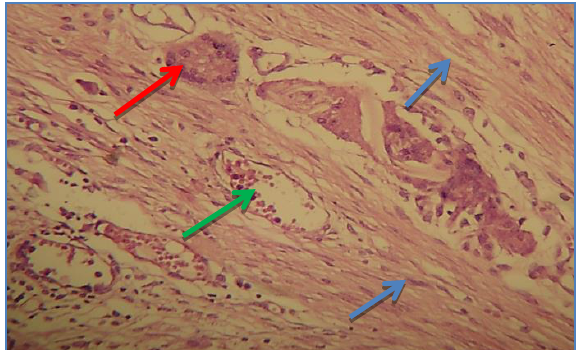
Figure, 12: Stomach of (G2), 21st p.o. showed dense regular fiberues tissue (blue arrow) with few congested blood capillarries contain neutrophils in their lumina (green arrow) and foreign body giant cells formation (red arrow) H and E